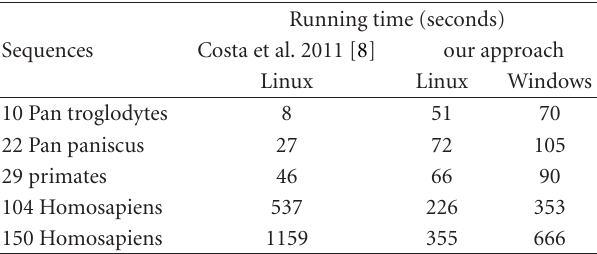
Table 1: Comparison of the running times between our approach (Linux and Windows x32 operative systems) and Costa et